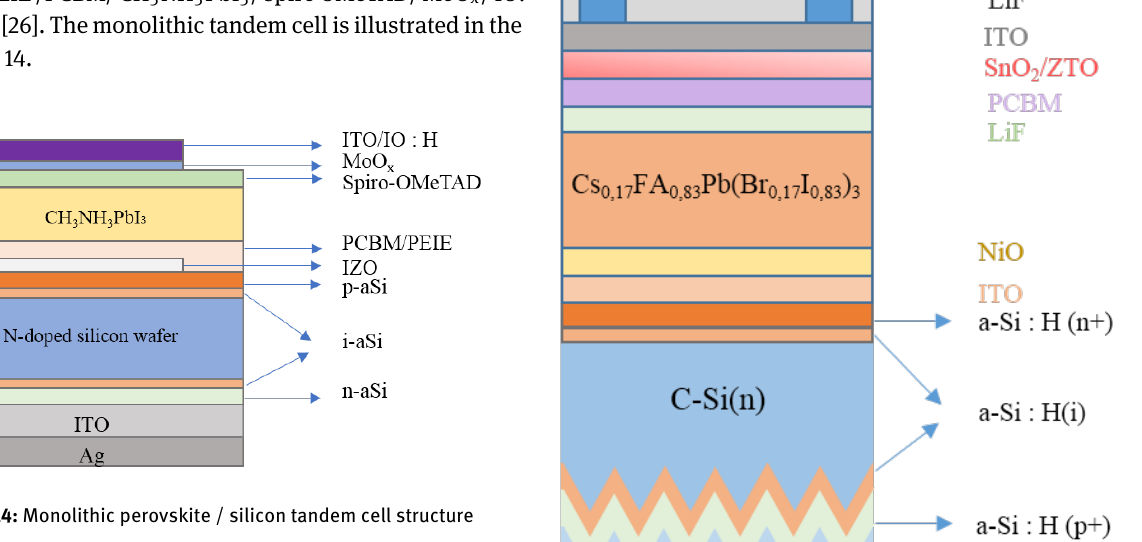
This configuration lead respectively to 18,1% and 17.2% efficiencies for 0,17 cm 2 and 1.22 cm 2 aperture ar- eas,respectively.Furthermore,thismonolithictandemcell reached a record efficiency of 19.2% for an aperture area of 1.22 cm 2 and 21.2% for 0.17 cm 2 , using an antireflective layer [26].